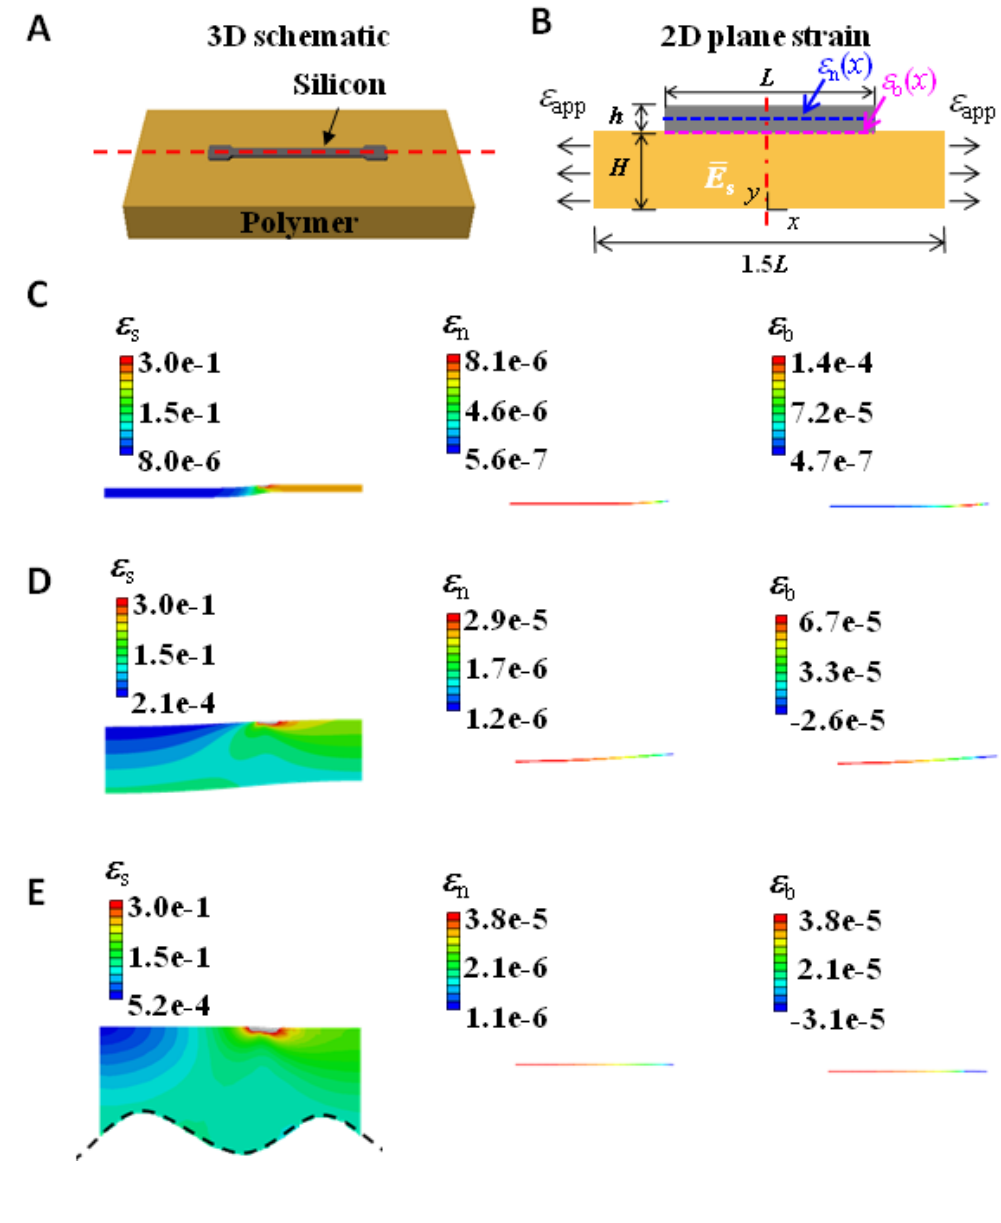
Figure 1. Schematic and FEM contour plots of a thin silicon strip supported by polymer substrate subject to uniaxial tension. ( A ) 3D schematic of a unit cell. ( B ) 2D plane strain model adopted in FEM. ε ( x ) represents strain along the neutral axis of silicon and ε ( x ) n b represents strain along the bottom surface of silicon. Due to symmetry, only the right half in (B) is modeled in FEM. ( C ) Contour plots of ε in substrate and ε and ε in silicon when s n b E = 60 kPa and H = 30 µm, ( D ) H = 300 µm, and ( E ) H = 3,000 s